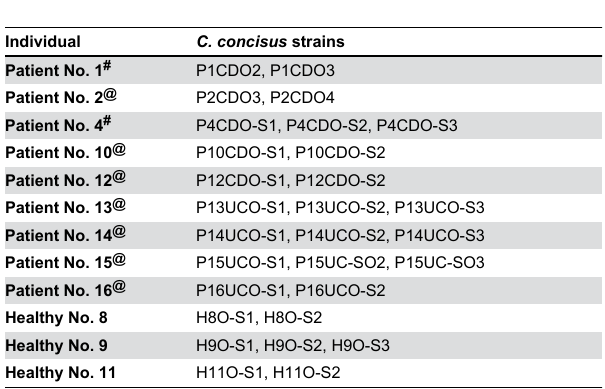
Table 3. Individuals who were colonized with multiple oral C. concisus strains.